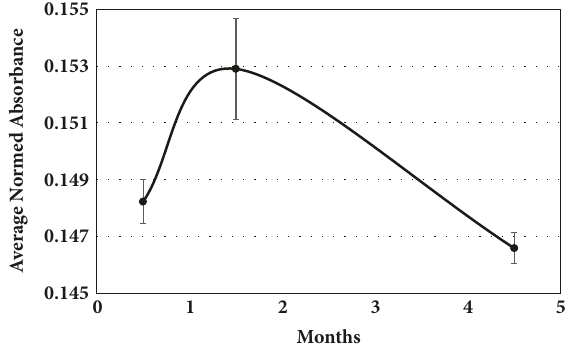
Figure 6: Variation ( ± 1 SE) in the unsaturation proxy (the normed absorbance at 3009 cm - 1 due to the cis C=C-H stretch) as measured by ATR-FTIR during the 5 month study.